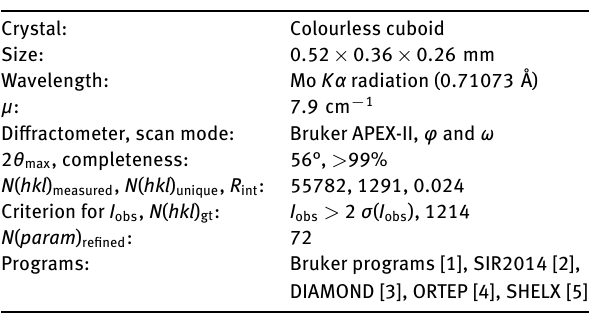
Table 1: Data collection and handling. Crystal: